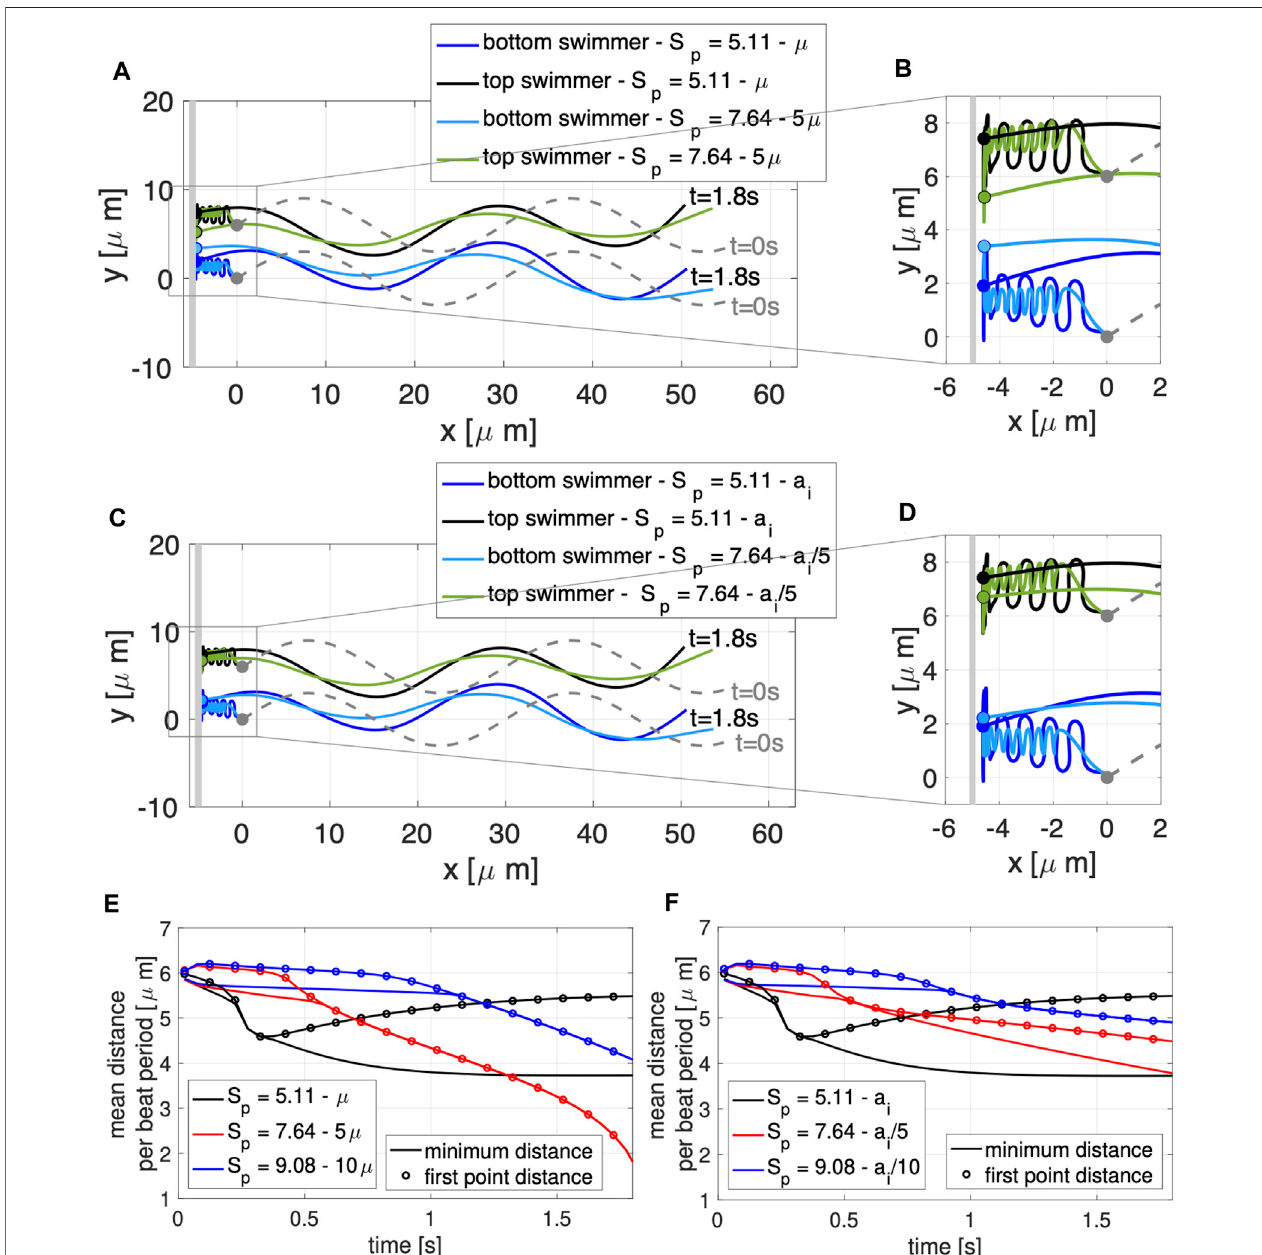
FIGURE 4 | Varying Sperm Number: Co-Planar Sperm Near a Wall. Swimmers with planar preferred beat forms are initialized a distance d (cid:1) 6 μ m apart with a planar wall at x (cid:1) − 5 μ m. Con fi gurations at t (cid:1) 0 s (gray dashed lines) and t (cid:1) 1.8 s (colored solid lines) are shown along with traces of the fi rst point on the fl agellum for varying fl uidviscosityin (A) ,withzoomed inviewin (B) ,and varying fl agellar material parameters a i in (C) ,withzoomed inviewin (D) .Thethick grayverticallinein (A) – (D) representsthewall.Theminimumdistancebetweenthetwoswimmers(solidlines)anddistancebetweenthe fi rstpointsofthetwoswimmers(circles)areshownas averages over a beat period, varying μ in (E) and a i in (F)